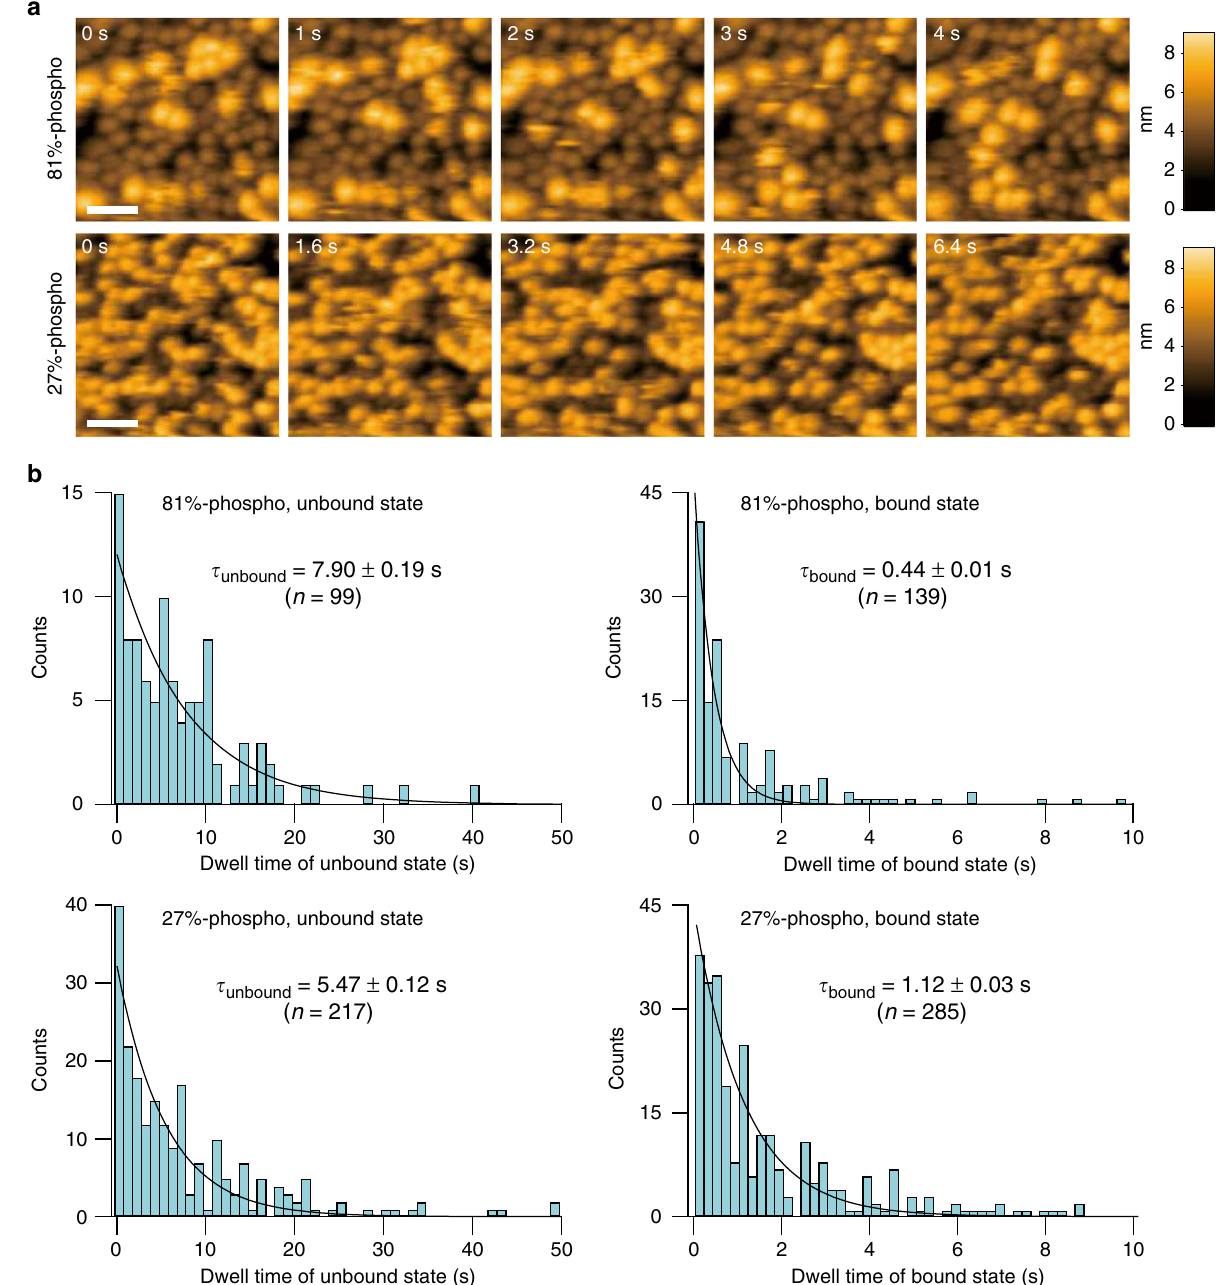
Fig. 5 The values of τ bound and τ unbound depend upon KaiC ’ s phospho-status. a HS-AFM images of KaiC and KaiA interaction. Native KaiC hexamers (KaiC WT ) that were approximately 81% phosphorylated (upper panels) or approximately 27% phosphorylated (lower panels) were immobilized on AP- mica surfaces and KaiA was added ( fi nal concentration of 0.4 µ M) to the observation buffer. Images were acquired at a frame rate of 1 fps (upper) and 1.25 fps (lower). Brighter spots show KaiA bound to surface-immobilized KaiC. Scale bars = 30 nm. Also see Supplementary Movies 17, 18. b Dwell time analysis for KaiA-bound and KaiA-unbound states of hyperphosphorylated (81%; top) and hypo-phosphorylated (27%; bottom) KaiC. Each black line overlaid on the corresponding histogram of dwell time was obtained by fi tting the histogram to a fi rst order reaction model with a time constant ( τ bound or τ ‘ n ’ shown in each graph indicates the number of detected events used for the unbound ) shown.